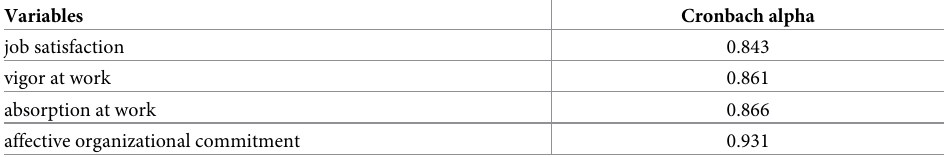
Table 12. Reliability analysis for I-HAW